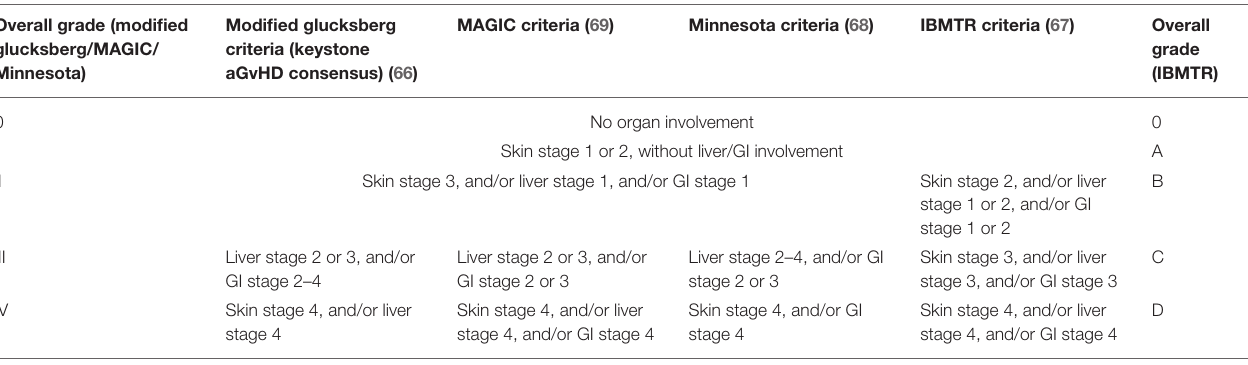
TABLE 2 | Assessment of aGvHD assessment: overall severity grading according to the different classifications. Overall grade (modified glucksberg/MAGIC/